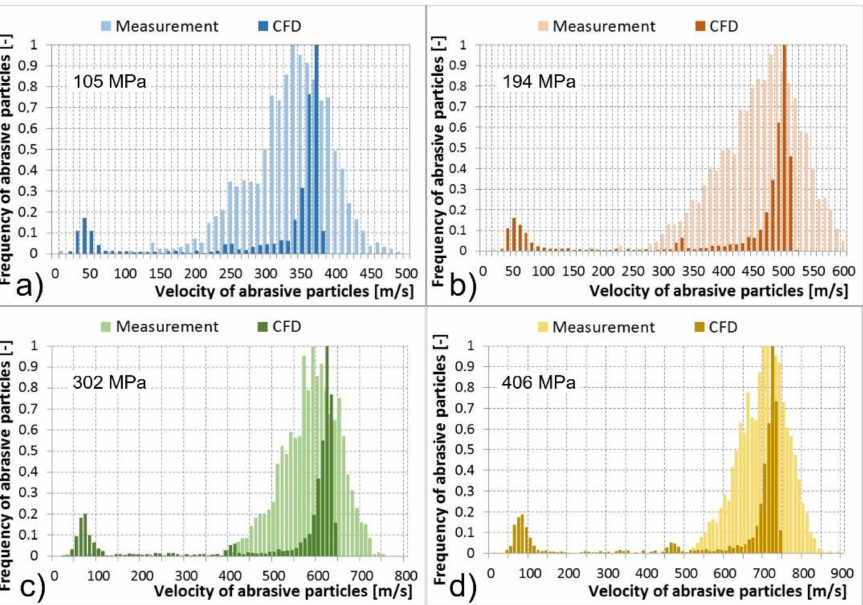
Figure 13. Abrasive particle velocities at the abrasive nozzle, measurement vs. computational models for given water pressure levels, and an abrasive particle mass flow rate of 100 g/min: ( a ) 105 MPa; ( b ) 194 MPa; ( c ) 302 MPa; ( d ) 406